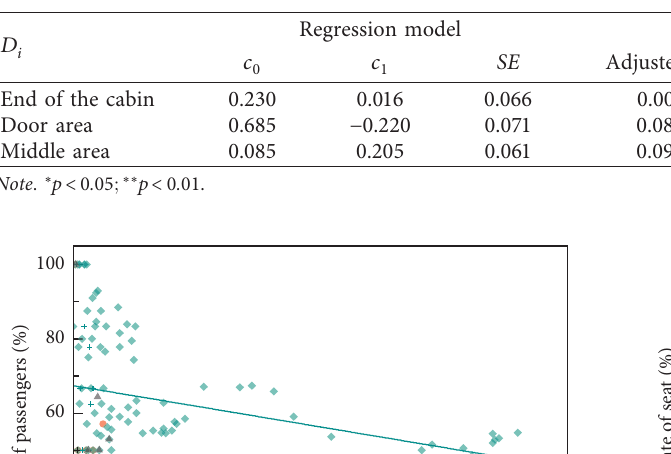
Table 5: An explanatory model for the proportion of passengers in the area.